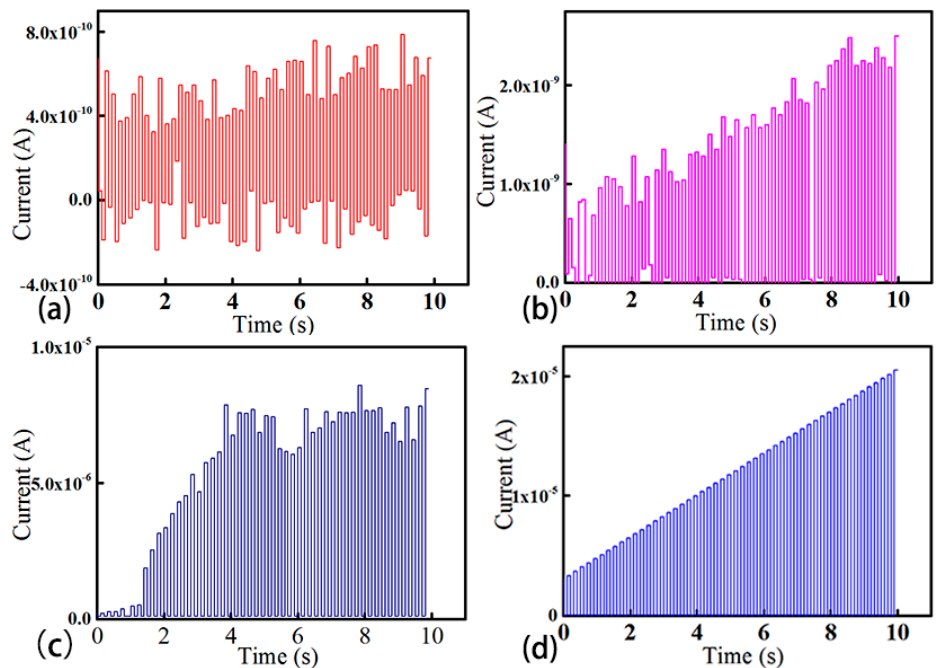
Figure 3. I–t curve of the device undergoing 50 voltage pulses with ( a ) an amplitude of 1 V; ( b ) an amplitude of 2 V; ( c ) an amplitude of 3 V; and ( d ) an amplitude of 4 V (100 pulses).